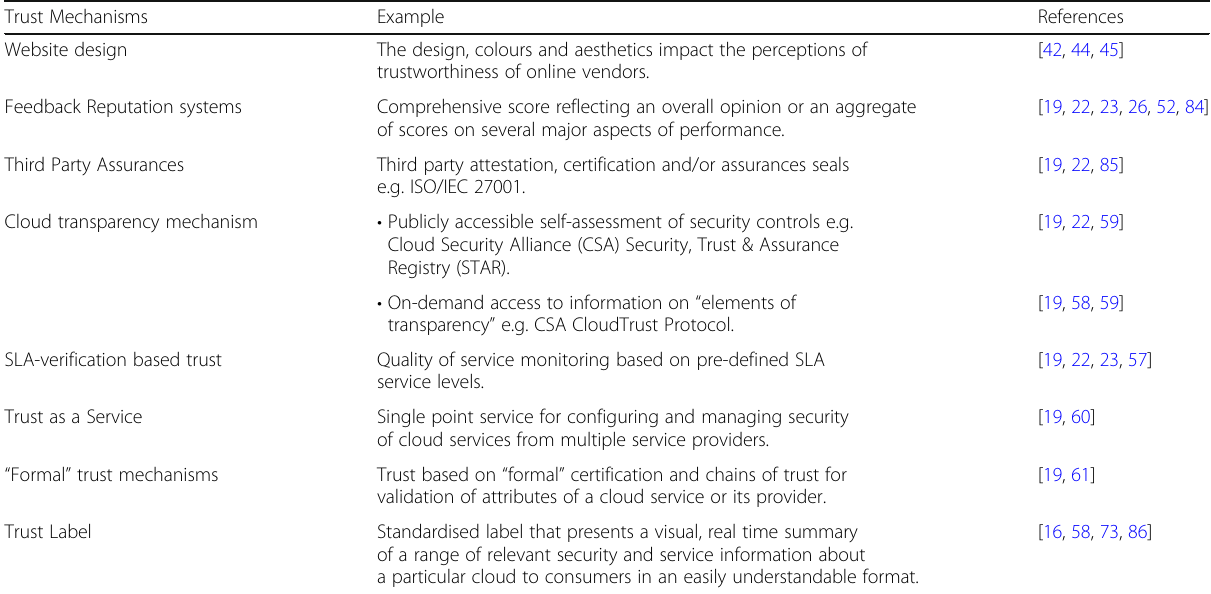
Table 1 Summary of Trust Mechanisms Impacting Cloud Computing Trust Mechanisms Example Website